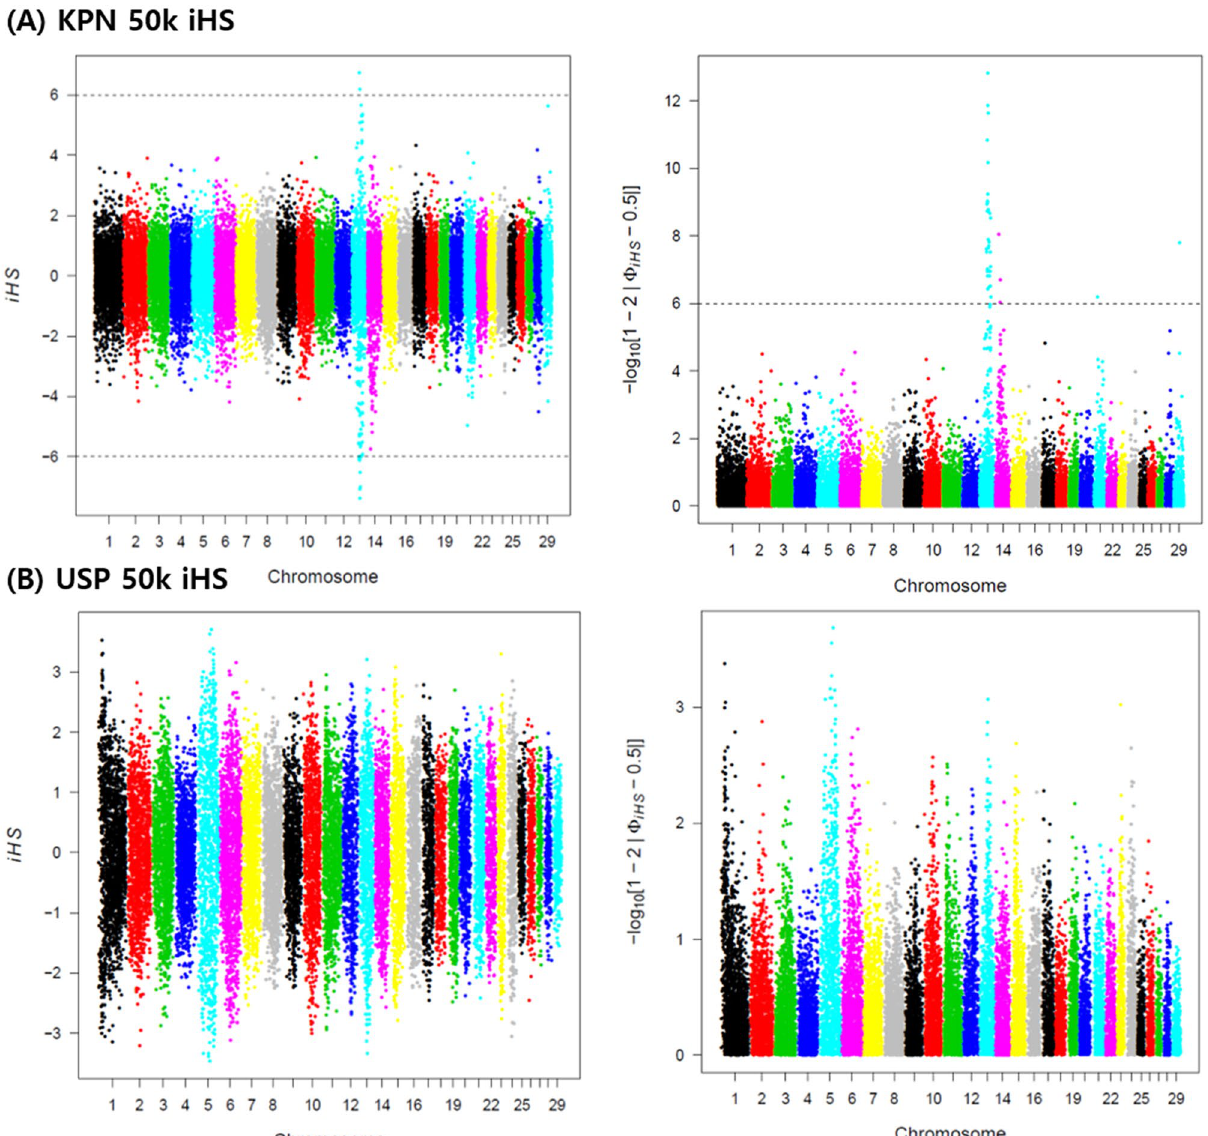
Figure 3. The integrated haplotype (iHS) results for selected (KPN) and unselected (USP) Hanwoo population: ( A ) is the iHS result of the KPN population and the right side is the piHS, which confirms the p-value of the calculated iHS value, ( B ) is the iHS and piHS value for USP population, respectively. The significant association of signature of selection was confirmed only KPN